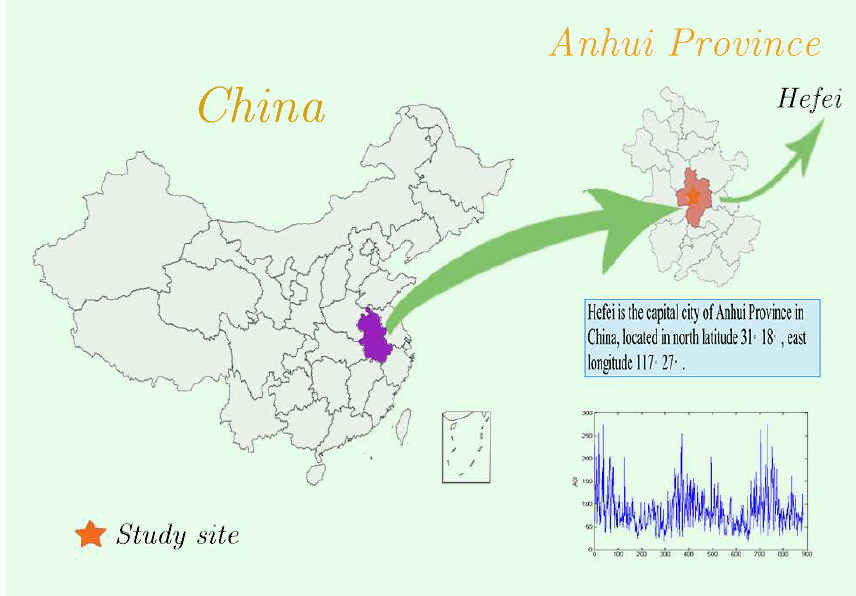
Figure 1. Geographic location of Hefei in